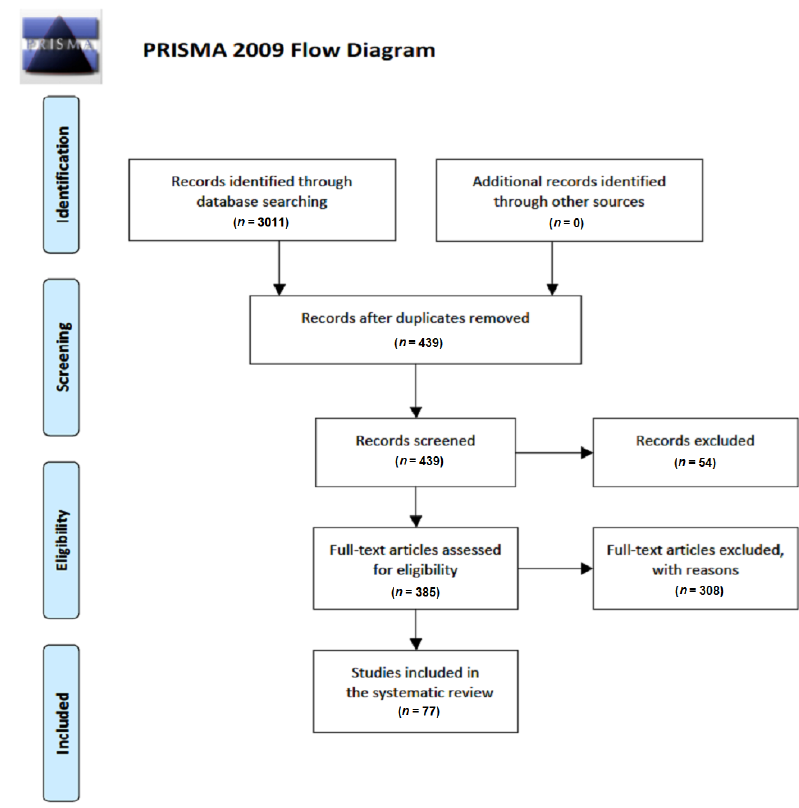
Figure A1. PRISMA Flow Diagram.